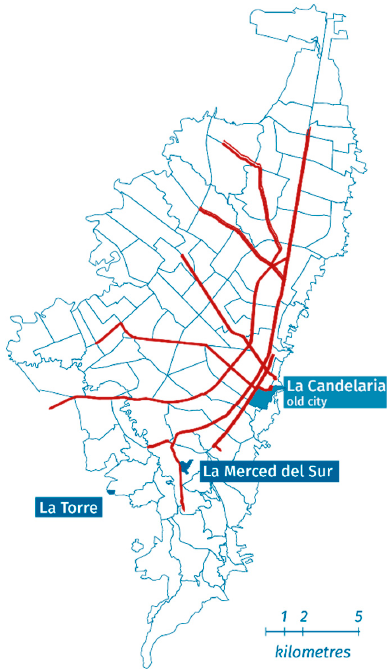
Figure 1. Position of the two examined neighbourhoods (source: [50]).